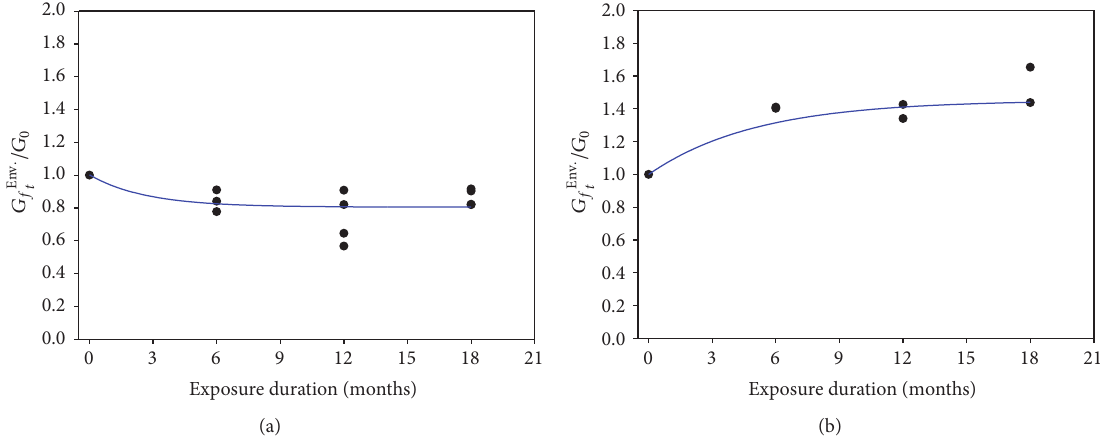
/𝐺 = 0.8+0.2𝑒 (−0.35𝑡) . (b) Effect of exposure 𝑓 𝑡 /𝐺 = 1.45 − 0.45𝑒 (−0.20𝑡) 𝑓 𝑡